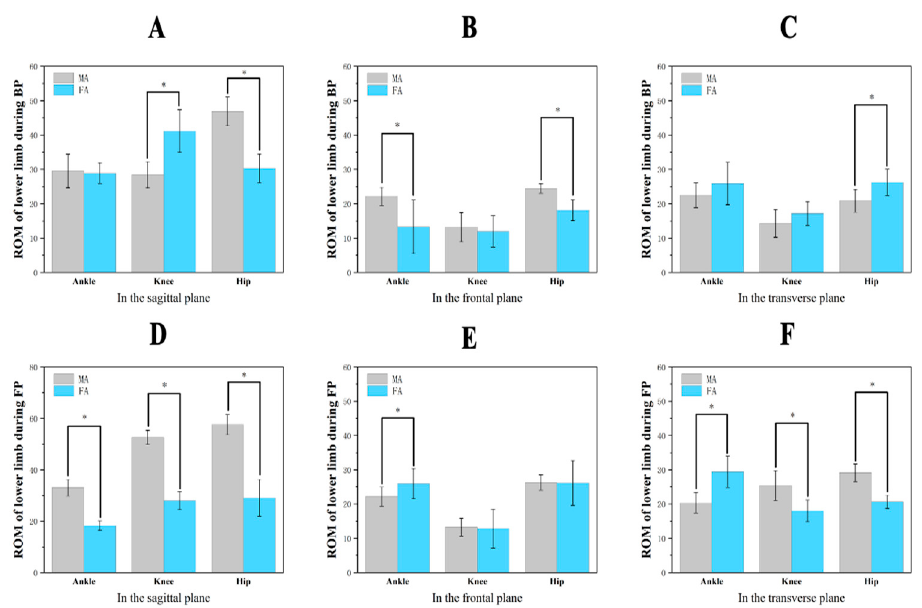
Figure 5. Comparison of ROM values in the BP and FP between MA and FA. ( A – C ) Lower limb ROM changes during the BP in three planes. ( D – F ) Lower limb ROM changes during the FP in three planes. * Significant differences at the hip, knee, and ankle ( p < 0.05).